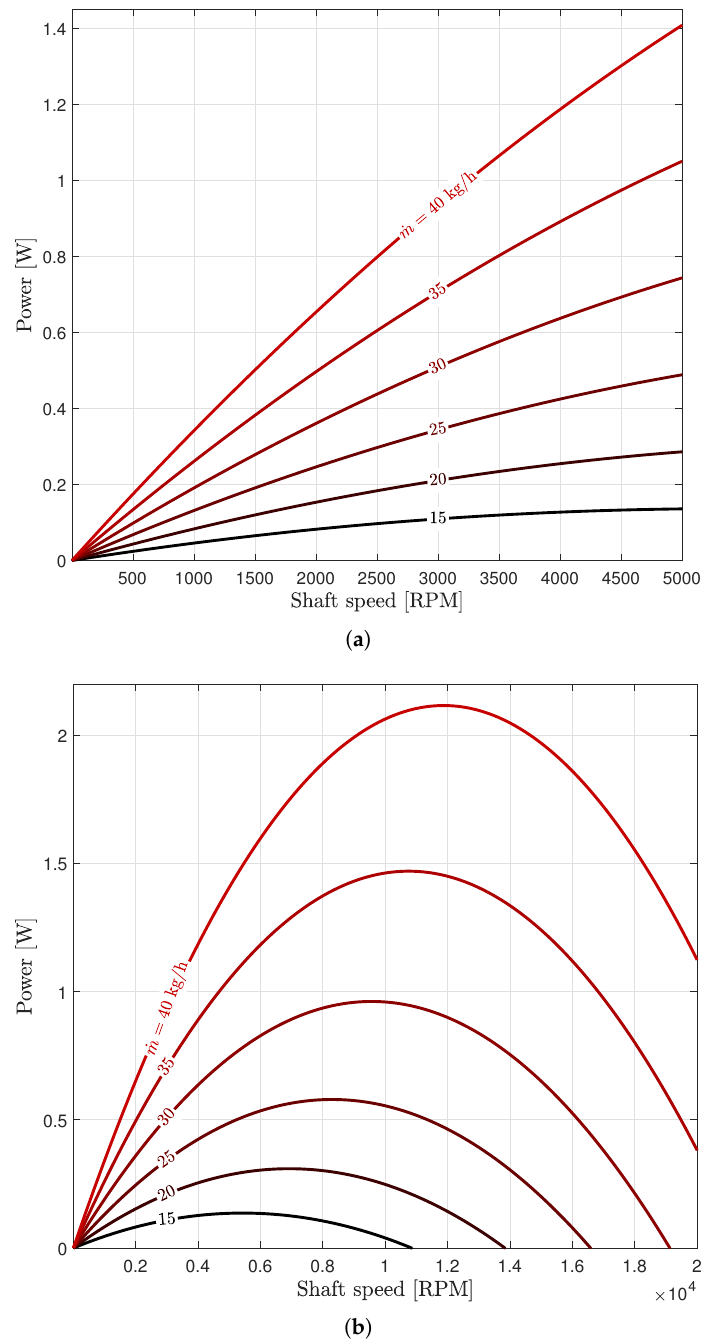
Figure 4. Generated power vs. shaft speed for several mass flow rates. ( a ) Shows the power generated by a shaft speed of up to 5000 RPM. ( b ) Shows the torque generated by a shaft speed of up to to 20,000